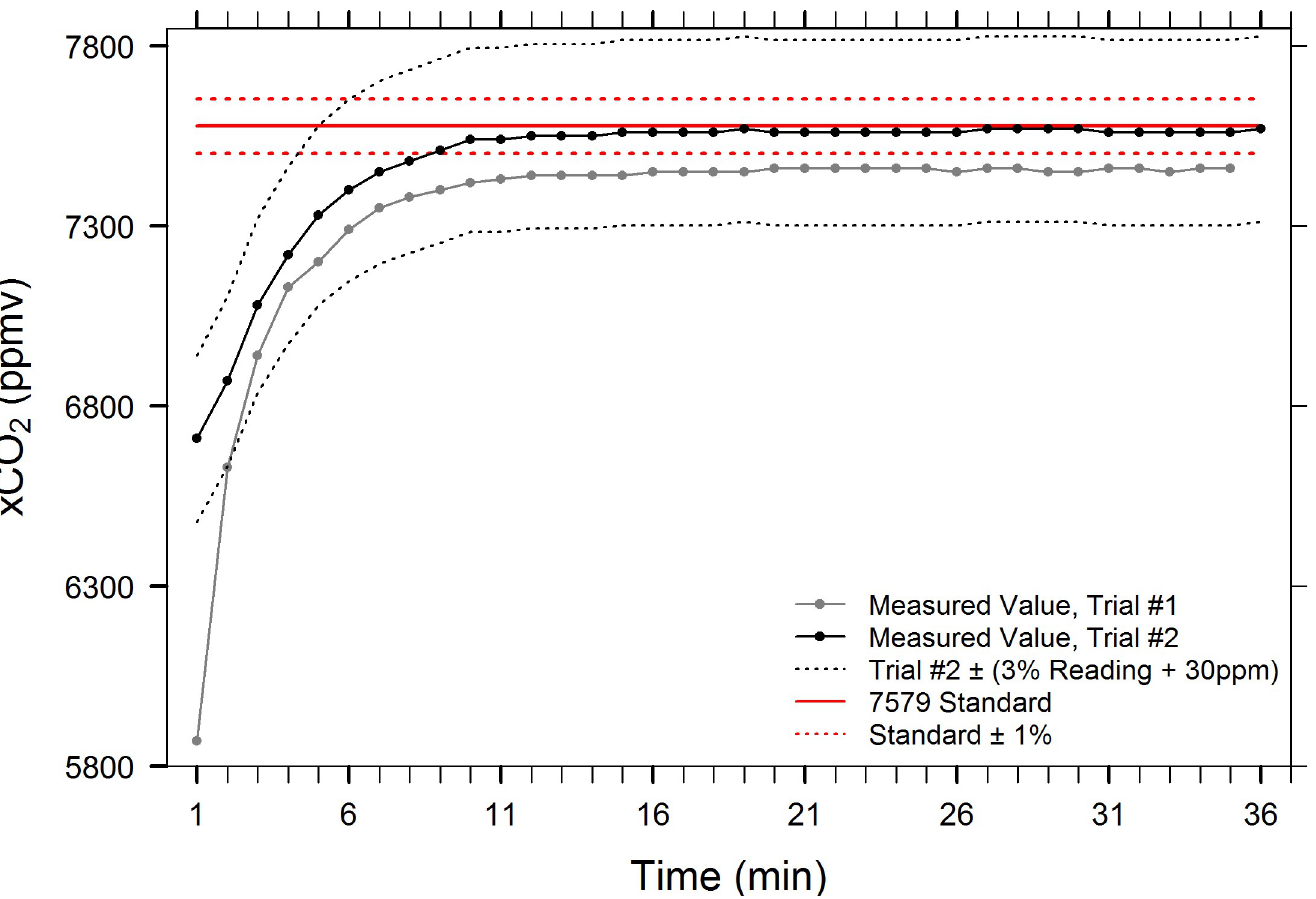
Fig 6. Accuracy test of 3.7-in EQL using 7579 ppmv ± 1% (nominal CO 2 concentration). Test #1 failed to reach the 7579 ppmv target, reaching an asymptote Accuracy test of EQL using 7579 ppmv ± 1% (nominal CO 2 concentration). Once equilibration initially reached within 1% of standard gas concentration, the average xCO 2 = 7578 ± 12.2 (mean ± 1 SD, n =